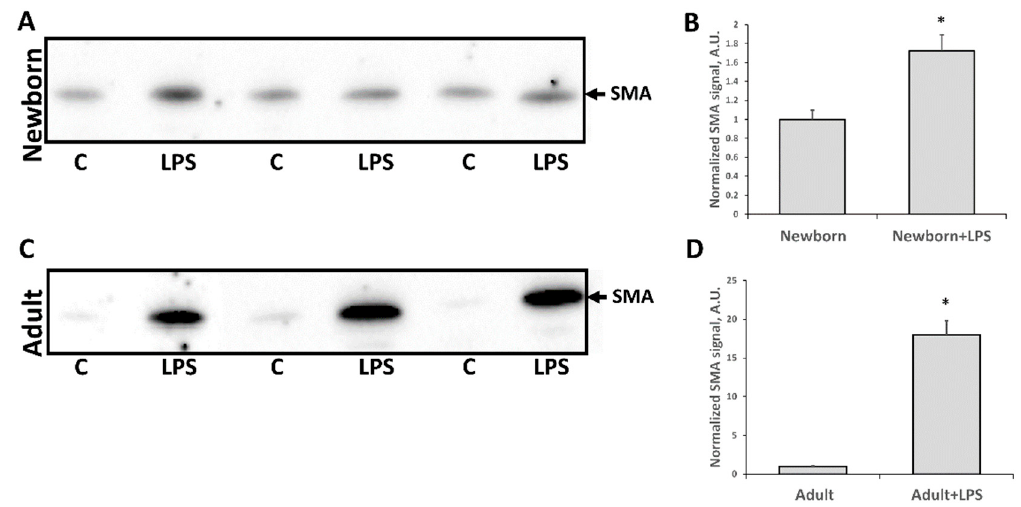
Figure 7. Kidney fibrosis, estimated by α -smooth muscle actin (SMA) levels in kidney tissue two months after LPS treatment. ( A , B ) Immunoblots of kidneys of rats that received LPS in neonatal age and ( C , D ) rats treated with LPS in adult age. ( B , D ) Densitometry analysis of bands in neonates and adults, respectively. Number of animals for Western blot densitometry: Adult ( n = 6), Newborn ( n = 6), Adults + LPS ( n = 5), Newborn + LPS ( n = 5). *: p < 0.05.